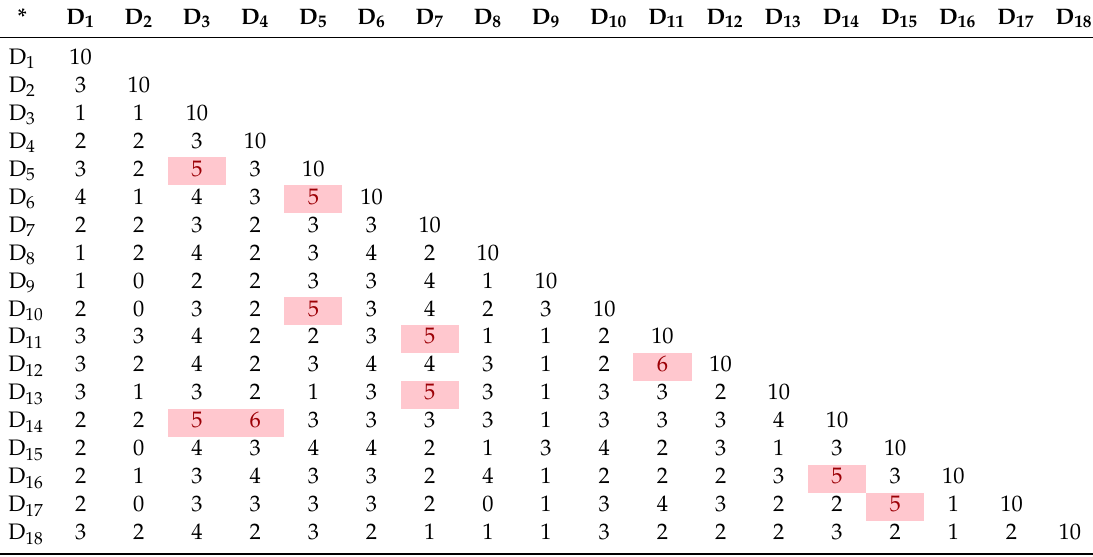
Table 10. Number of common factors within the top-10 between studies